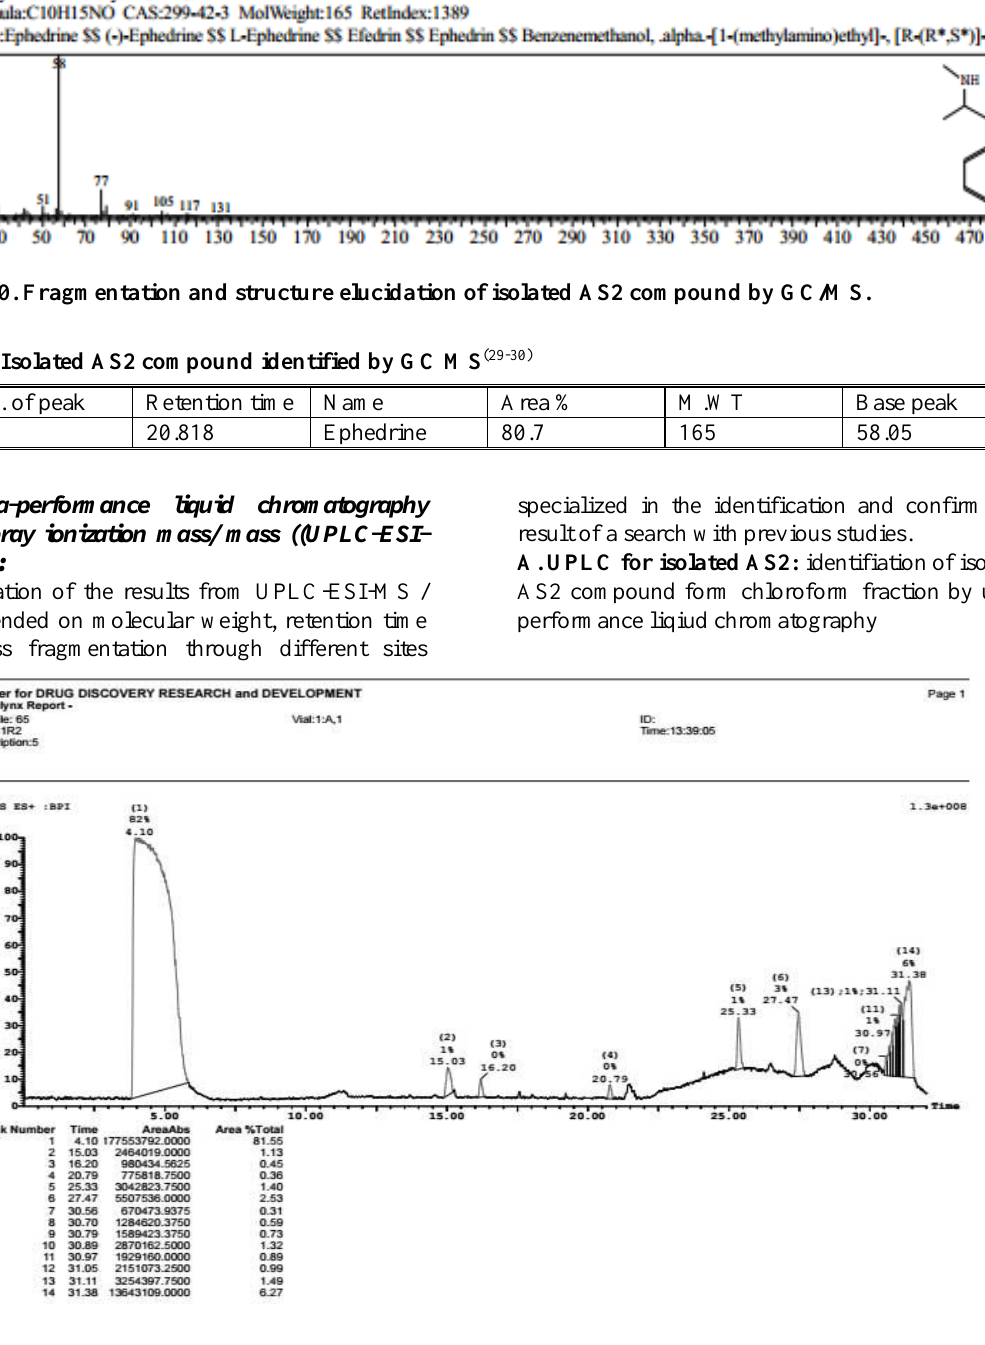
Figure 11. UPLC for isolated AS2 from chloroform fraction after